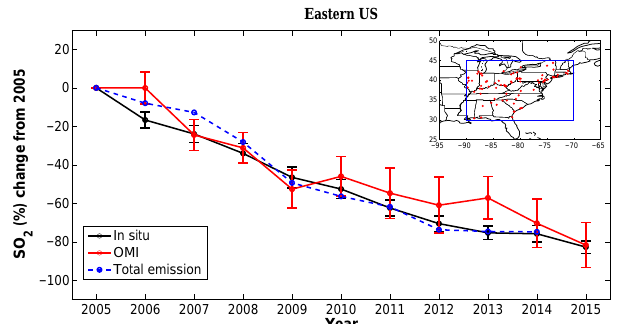
Figure 5. Percent change in the ground-level SO 2 mixing ratio from 2005 over the eastern US and southern Ontario, Canada. The in situ and OMI ground-level SO 2 percent change are shown in black and red color, respectively. Blue circles show changes in total SO 2 emis- sions. The locations of in situ measurement stations over the eastern US and southern Ontario, Canada (blue box), are shown in the inset map. The error bars represent the 1 standard error of the mean.